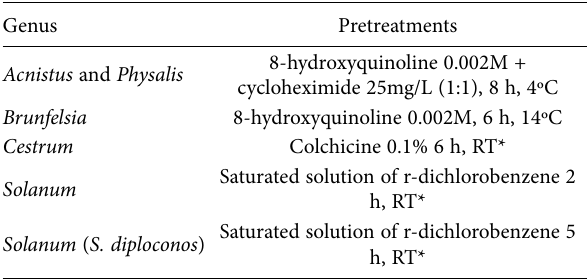
Table 2. Pretreatments used for each genus of Solanaceae studied.